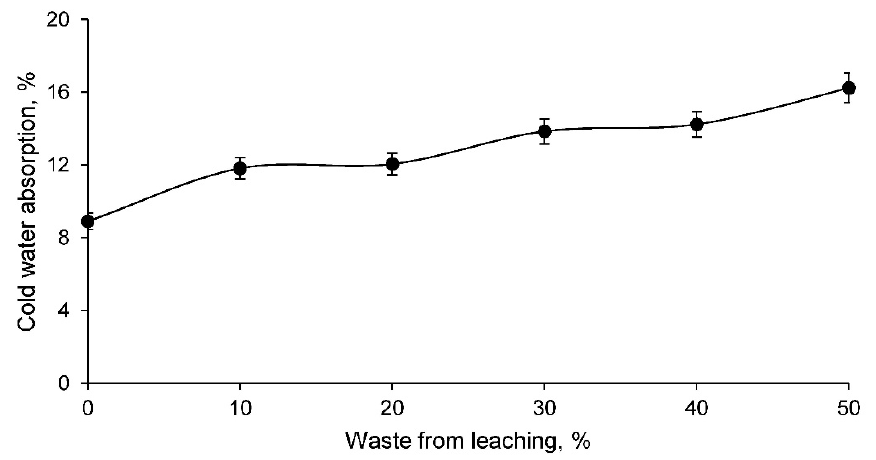
Figure 7. Cold water absorption of different families of clay-conformed ceramics and leaching residue.